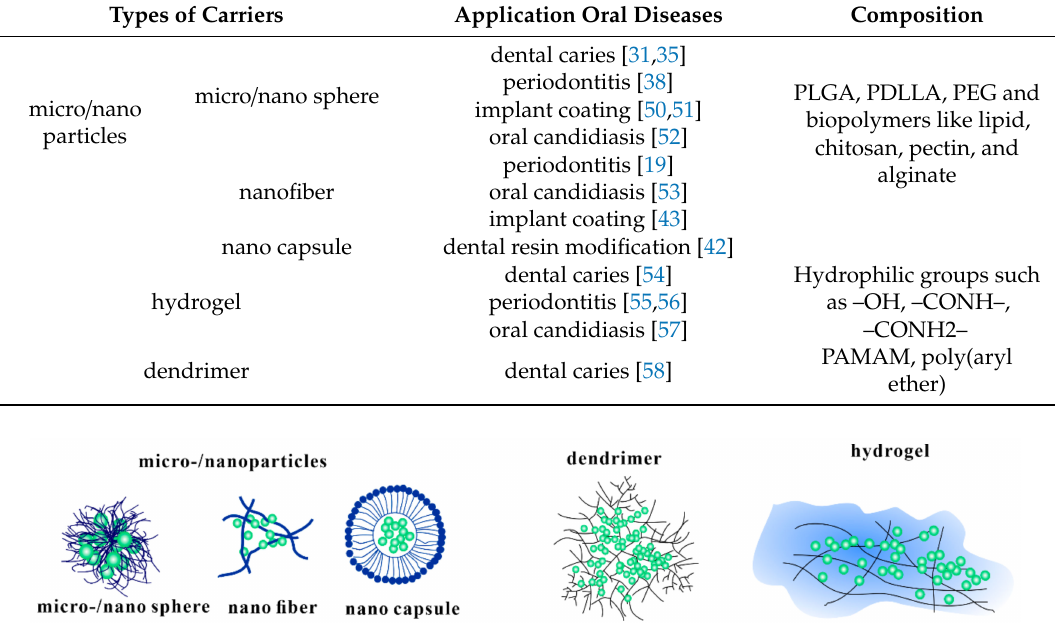
Figure 1. Examples of the structures of di ff erent kinds of